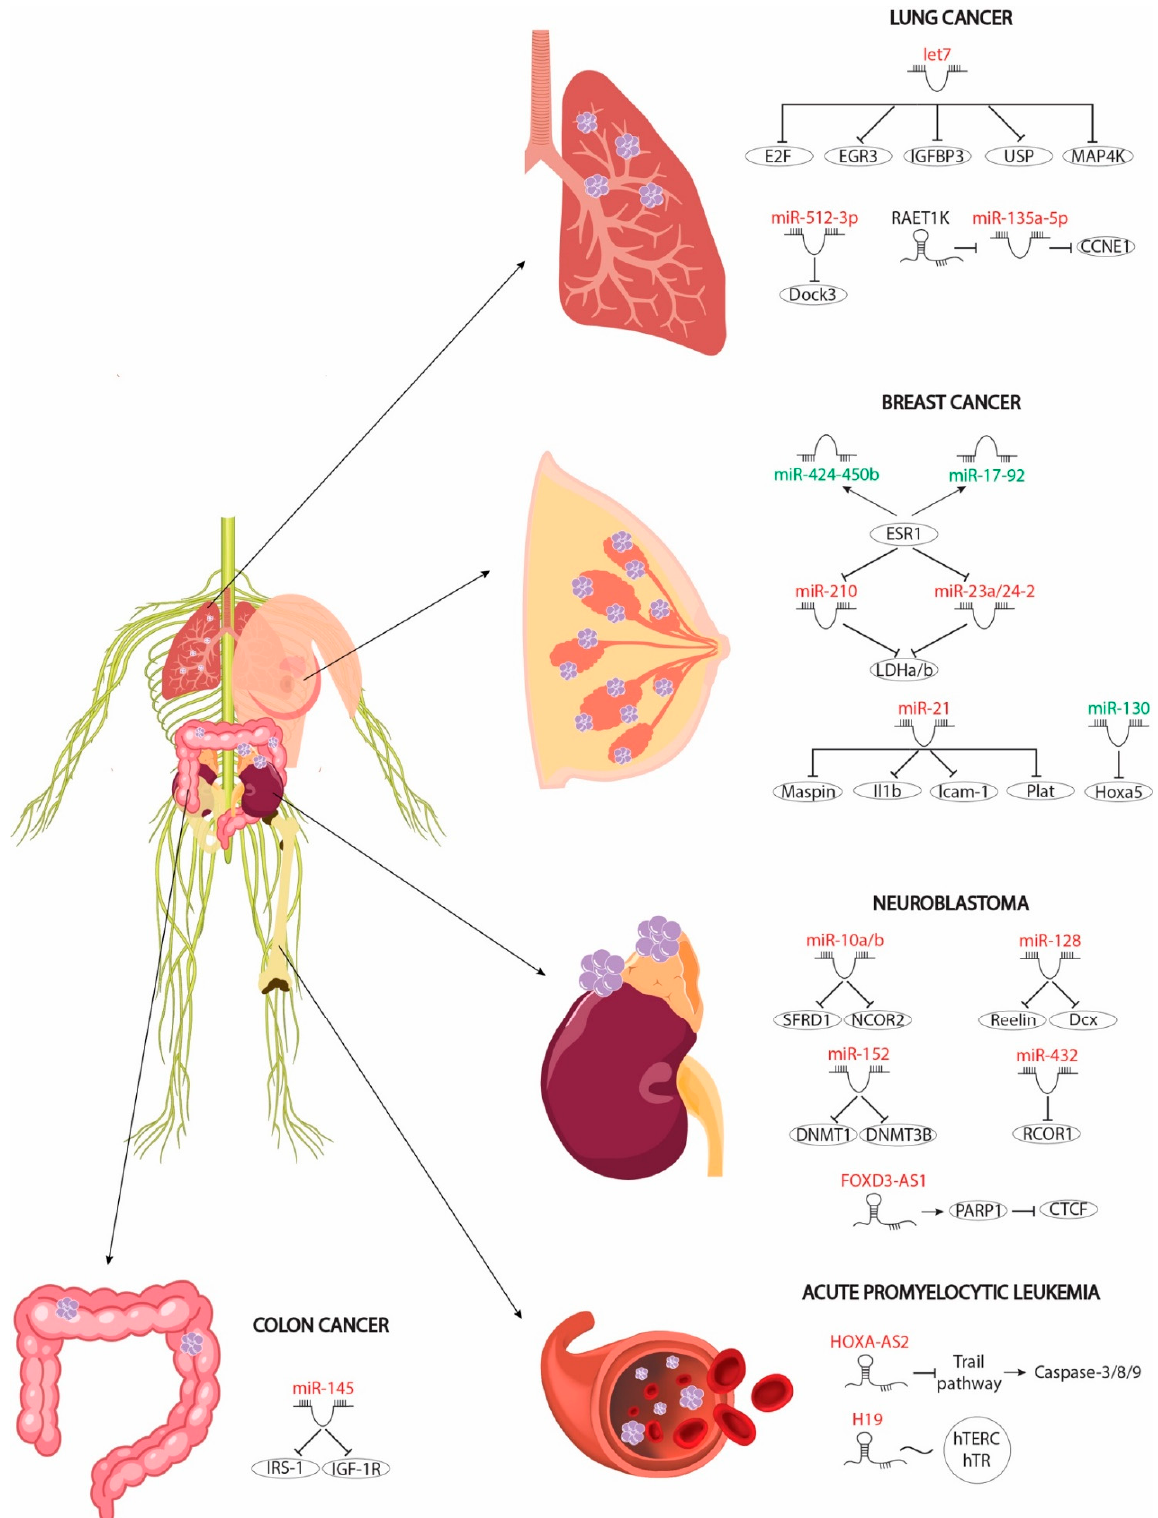
Figure 3. Schematic representation of the different non-coding RNAs involved in RA-regulated oncogenic pathways, including lung and breast cancer, neuroblastoma and acute promyelocytic leukaemia. MicroRNAs and lncRNAs that are upregulated after RA administration are depicted in red while those that are downregulated after RA administration are depicted in green.